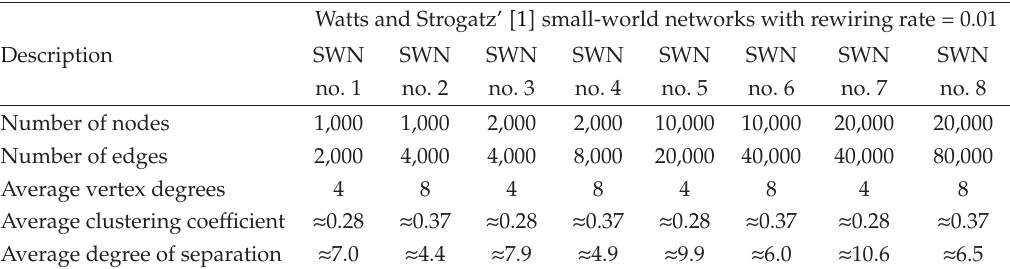
Table 6: Parameters for eight small-world networks built using di ff erent numbers of nodes and average vertex